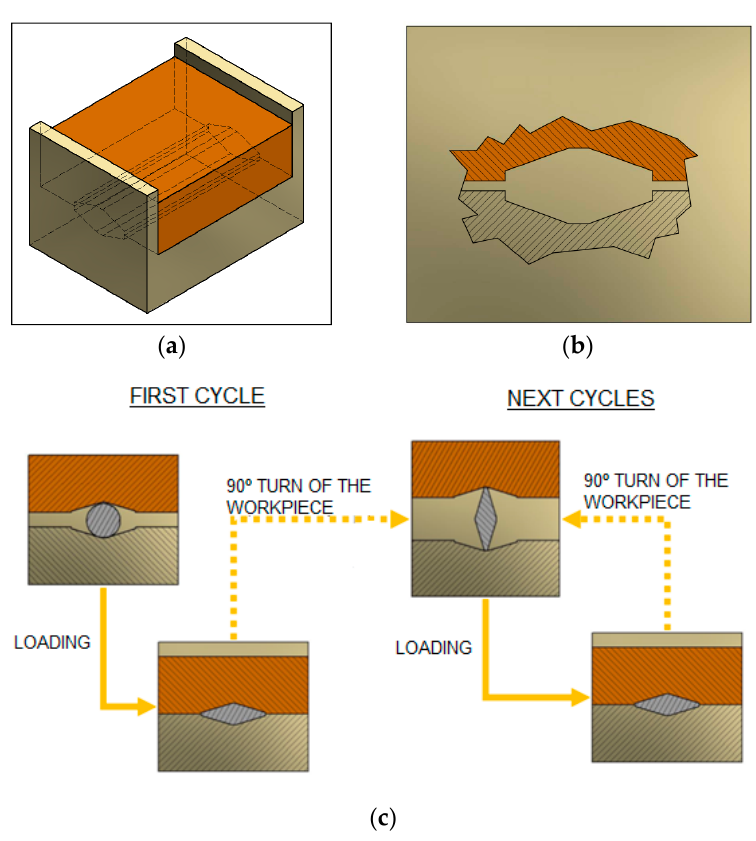
Figure 1. Schematic of continuous closed die forging (CCDF) including ( a ) the matrix configuration, ( b ) geometry of the dies, and ( c ) deformation sequence.